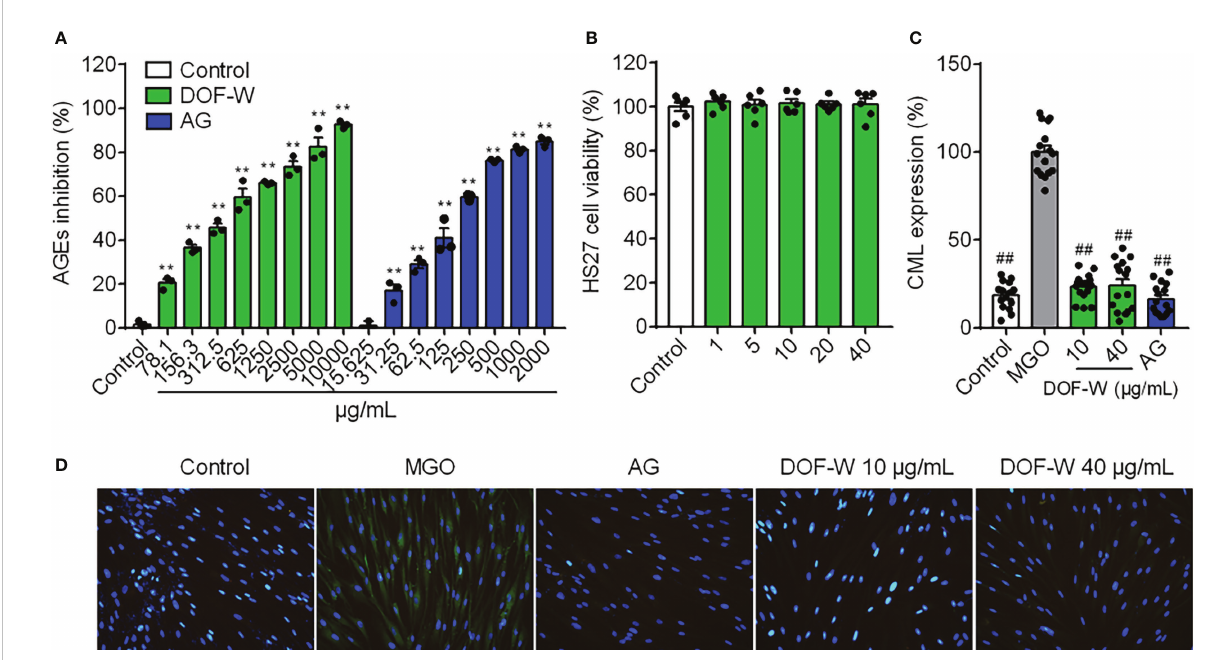
FIGURE 4 Anti-glycation activity of DOF-W. (A) Inhibition of fl uorescent AGEs by DOF-W extract. (B) Cytotoxicity of DOF-W extract to fi broblasts. (C) Effect of CML expression in glyoxal-induced HDFs by DOF-W extract. (D) Representative images of HDFs by fl uorescence microscope and statistics. ## p< 0.01 compared with the MGO model. ** p< 0.01 compared with control. AG, aminoguanidine hydrochloride; MGO, methylglyoxal; CML, N - carboxymethyl